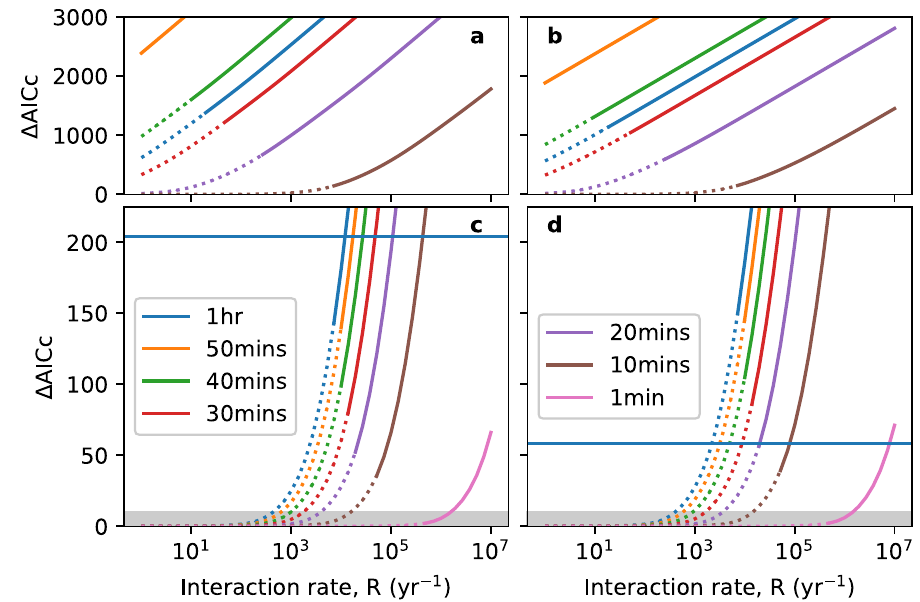
Fig 6. Δ AIC c in the usage-based model as a function of interaction rate R for the definite (panels a and c) and indefinite (b and d) articles. Along each curve, the memory time T = 1/( R � ) is held constant. In panels a and b, T M M ranges from 25 years (top line) to 1 hour (bottom line). Panels c and d focus on the range of interest where greater plausibility than the child-based model is achieved: the horizontal lines correspond to the s = 1 asymptotes in Fig 5. Dotted lines indicate where the usage-based model is unphysical ( � > 1) and the shaded grey region indicates where the fit starts to become comparable to the Poisson baseline ( Δ AIC c < 10).